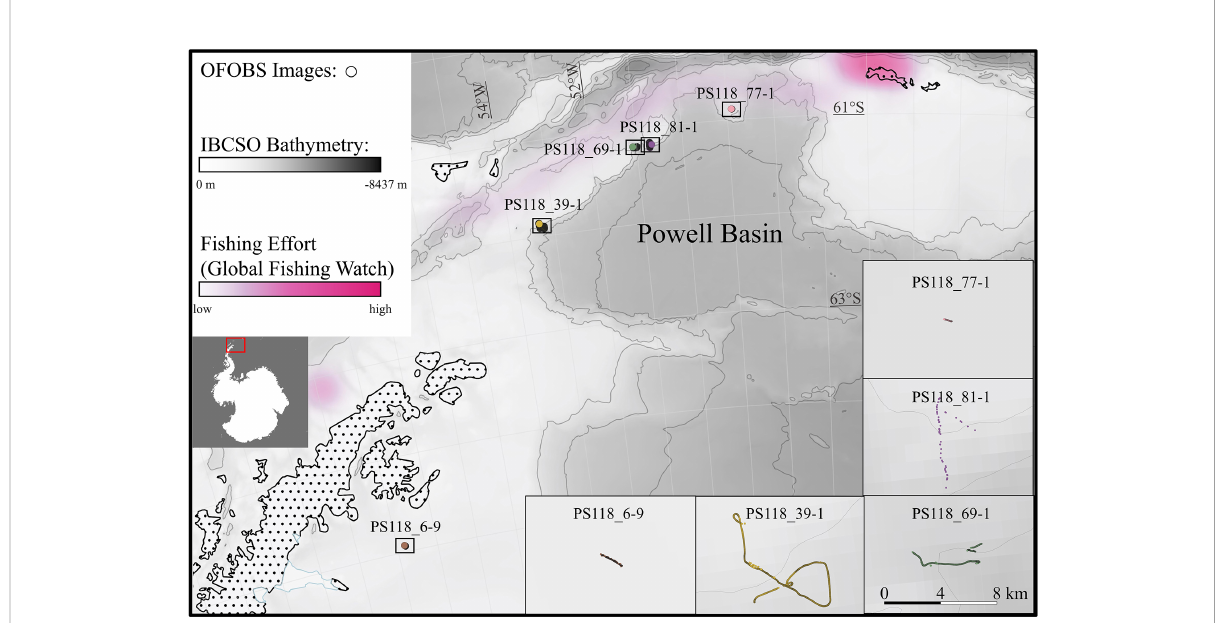
FIGURE 1 Location of the fi ve OFOBS (Ocean Floor Observation and Bathymetry System) image transects during cruise PS118 from which images were analyzed to detect food falls. Analyzed images are depicted as points. For transect PS118_69-1 1073 and for transect PS118_81-1 335 images are not shown because of missing meta data. IBCSO bathymetry is represented as a grey scale with isobaths each 1000 m (Dorschel et al., 2022). Fishing effort data from global fi shingwatch.org is represented with a pink heatmap, indicating fi shing effort from March 31 2019 when food falls “ Fish_1 ” , “ Fish_2 ” , and “ Fish_3 ” were found. The Antarctic Polar Stereographic projection was used to display the